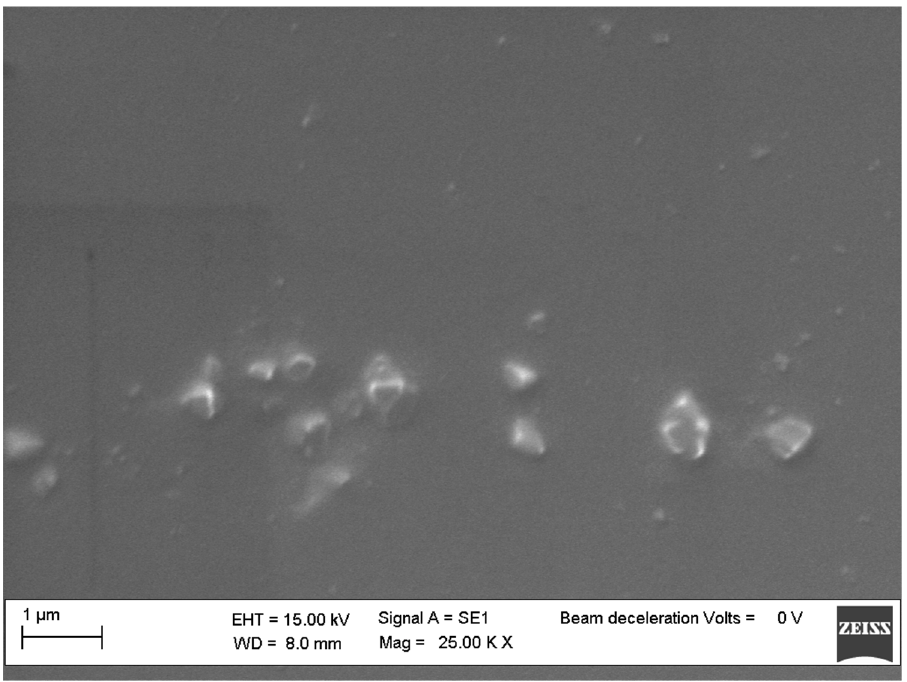
Figure 7. SEM images of PS/POSS 5 nanocomposites.